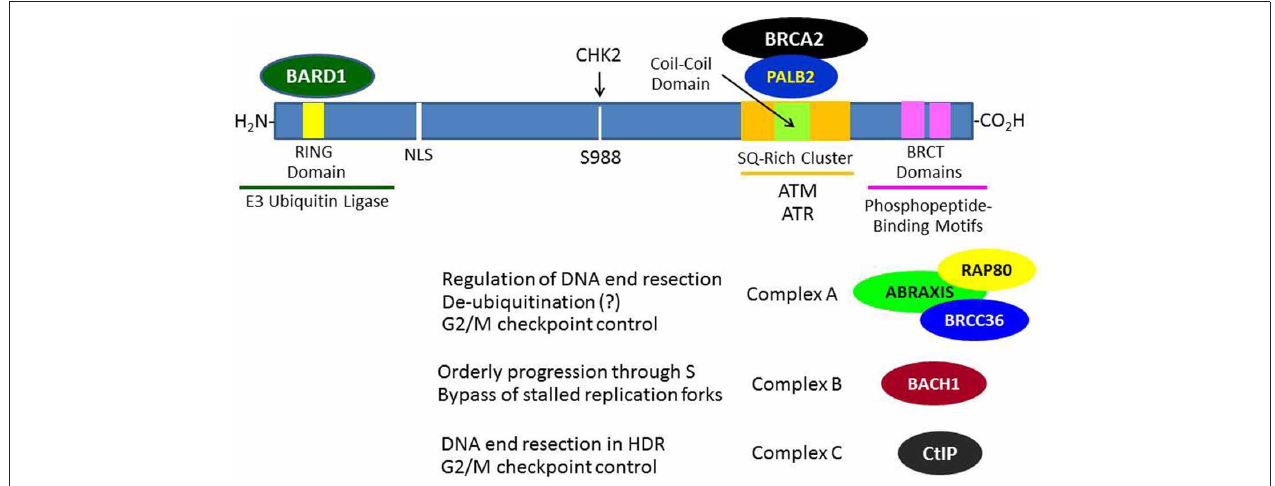
FIGURE 1 | Breast and ovarian cancer susceptibility gene 1 protein interactions that contribute to its role in the DNA damage response. In response to DNA damage, BRCA1 is phosphorylated at various sites by several kinases (e.g., ATM, CHK2, and/or ATR) and forms several different types of complexes that are recruited to the sites of DNA damage through various mechanisms. The roles of these complexes in DNA damage signaling and repair are only partially understood. The formation of these BRCA1